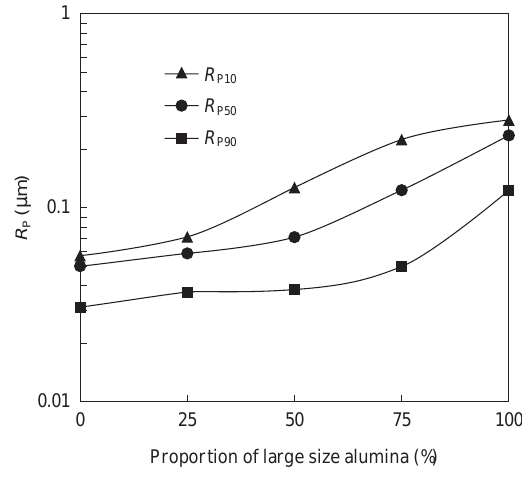
Fig. 11 Variation in pore size R P for particle size blended